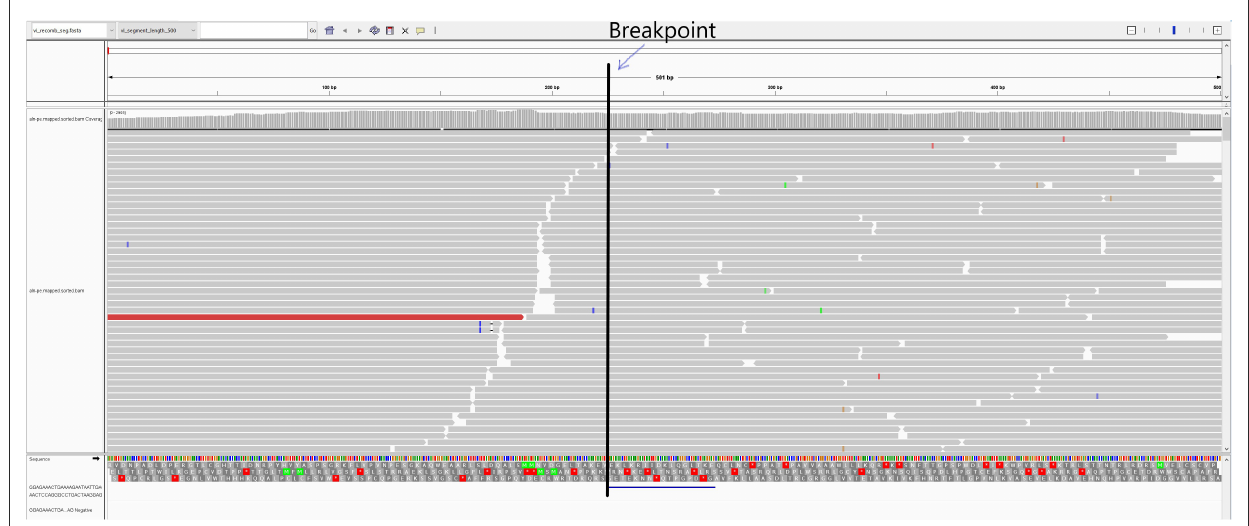
FIGURE3 IGV representation of the mapped reads and virus isolate USA/IN105404/2021. The vertical line represents the recombination breakpoint identified at the 7,243 nt position. The reads marked before the breakpoint line were identical to the Prevacent ® PRRS vaccine strain, whereas the reads after that matched the Ingelvac ® PRRS MLV vaccine